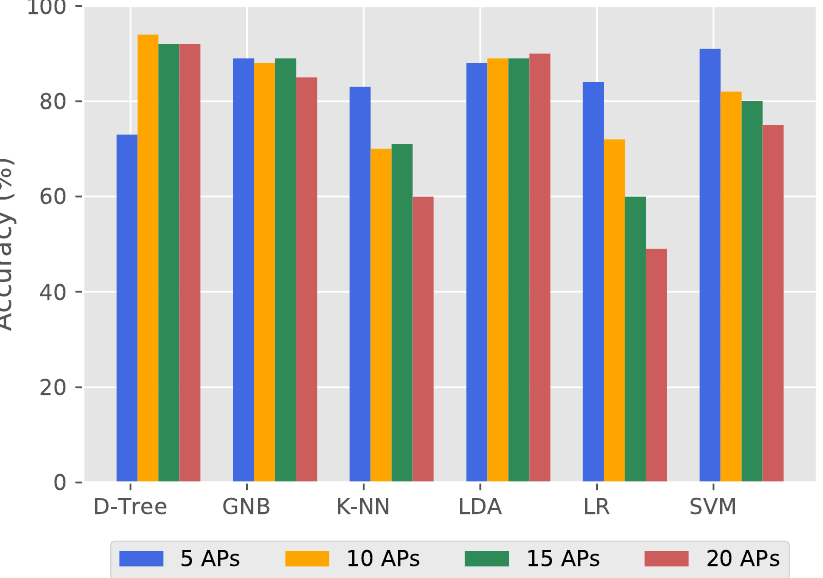
Figure 6. Average accuracy with a different number of APs using the Gauss–Markov mobility